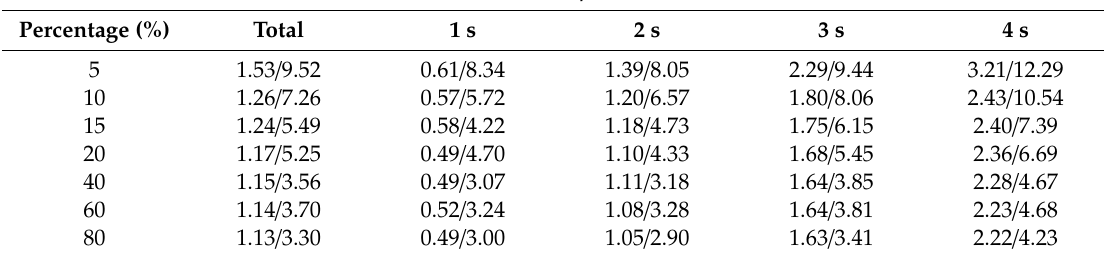
Table 2. Comparison of the weighted average displacement error (ADE) values between the proposed local curvilinear coordinates and the curvilinear